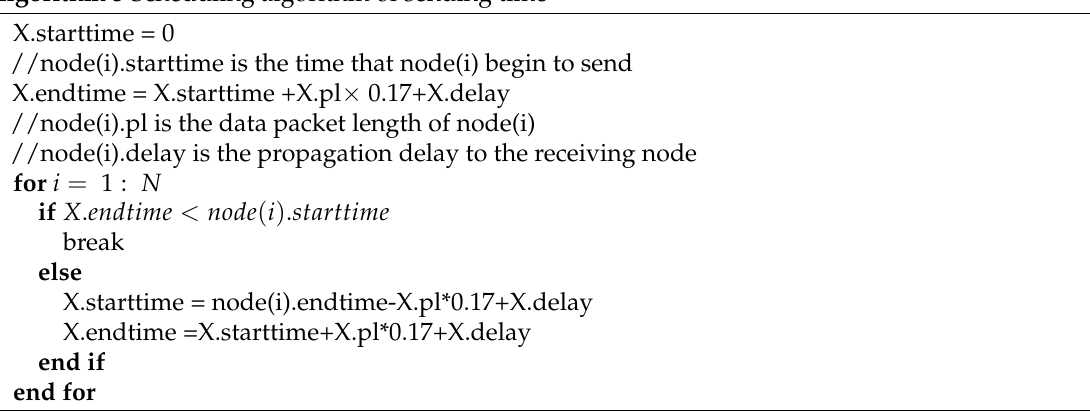
Algorithm 3 Scheduling algorithm of sending time